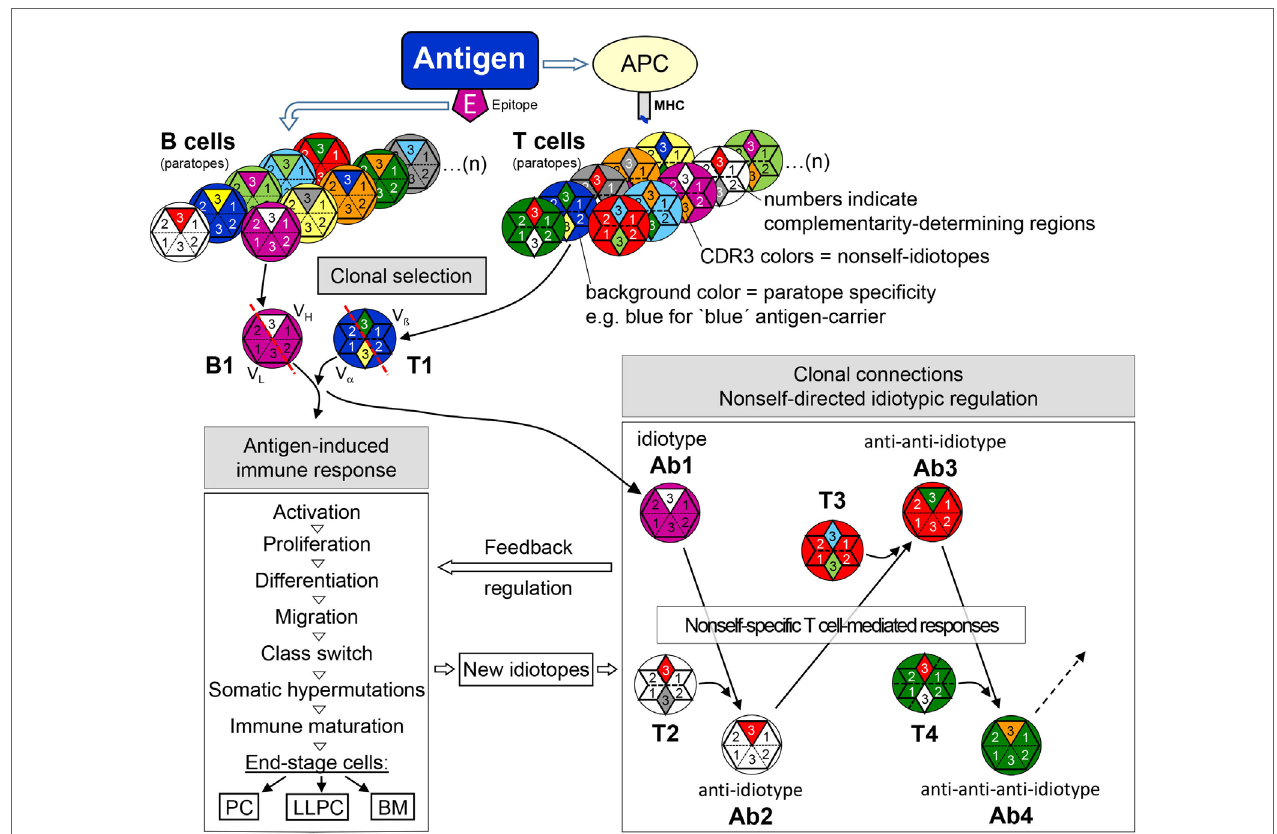
FiGURe 5 | The adaptive immune response—from clonal selection to nonself-directed idiotypic regulatory clonal connections. Antigen selects epitope-specific B cells and carrier-specific T cells from the respective repertoires. BCR/TCR background colors symbolize the specificity of a particular paratope (see legend to Figure 4 ), in this example, purple for the B cell epitope-specificity and blue for the carrier-specificity of T cells. After antigen-induced activation, CDR-H3 nonself-idiotopes (white) of antigen-specific idiotype (B1/Ab1—purple paratope) activates nonself-specific anti-idiotypic B cells (Ab2—white paratope) with the help of likewise nonself-specific anti-idiotypic T cells (T1—white paratope). In further reaction, nonself CDR-H3 portions of Ab2 (red) may be recognized and activate anti-anti-idiotypic B cells (Ab3—red paratope) with the help of Ab2-idiotype-specific T cells. This idiotypic cascade may proceed to anti-anti-anti-idiotypes (Ab4) and even further as shown for Ab6 (162). Thus, clonal selection and activation by antigen induces clonal connections of an idiotypic cascade that exerts a regulatory feedback on the ongoing antigen-induced response. During this response, in addition, somatic mutations create new nonself-idiotopes which may also induce an idiotypic feedback regulation. Abbreviations: APC, antigen-presenting cell; MHC, major histocompatibility complex; PC, plasma cell; LLPC, long-lived plasma cells; BM, B memory